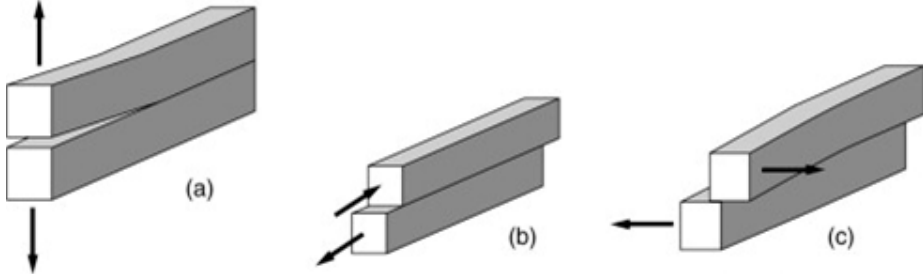
Figure 3. The three loading modes that promote the crack propagation: ( a )—Mode I (opening), ( b )—Mode II (in-plane shear), and ( c )—Mode III (out-of-plane shear). P